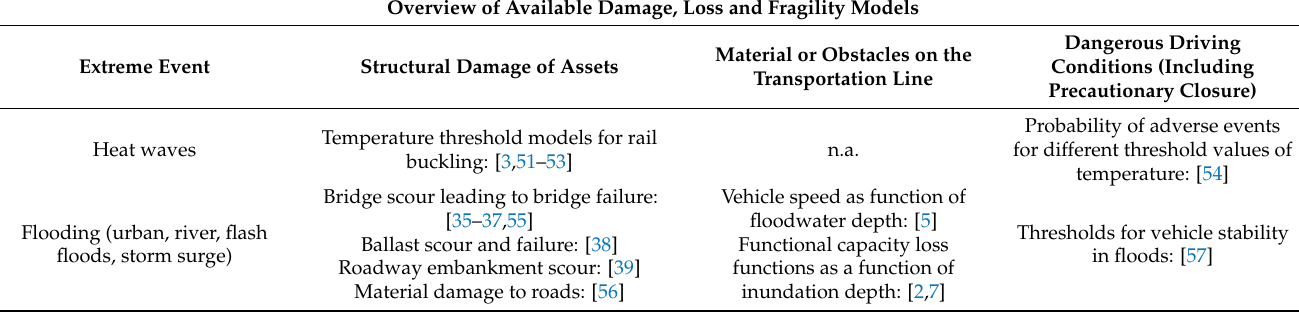
Table 2. Damage, loss and fragility models from the literature for different extreme events and failure modes/modes of malfunctioning (n.a. = not